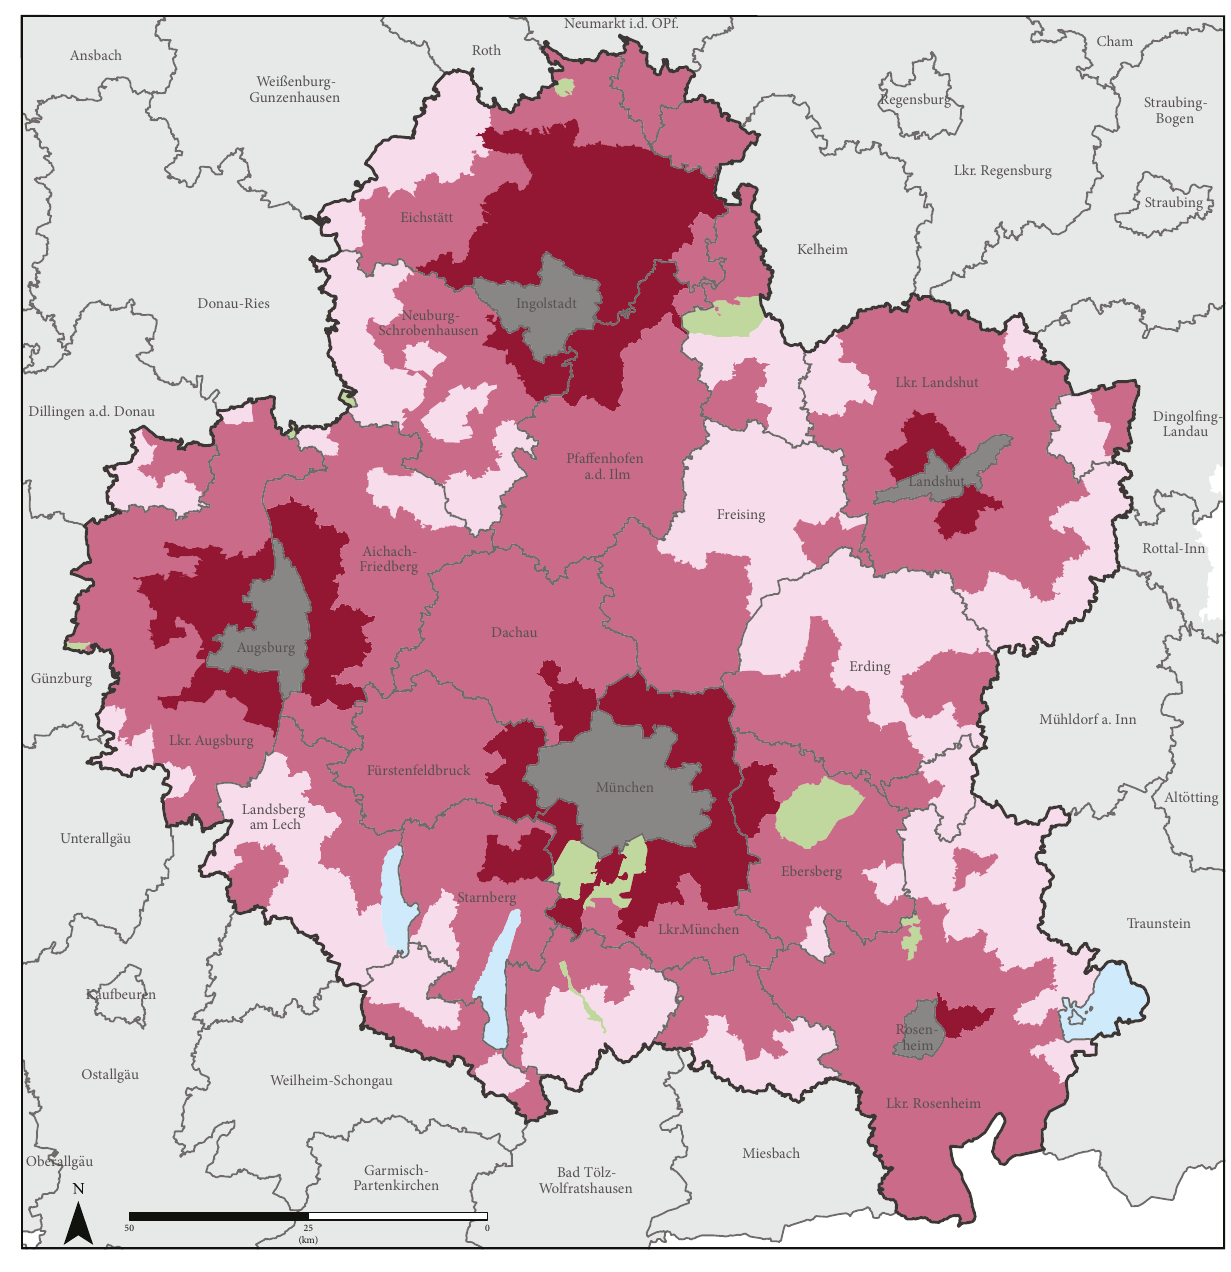
Figure 1: Delineation of the Greater Munich metropolitan